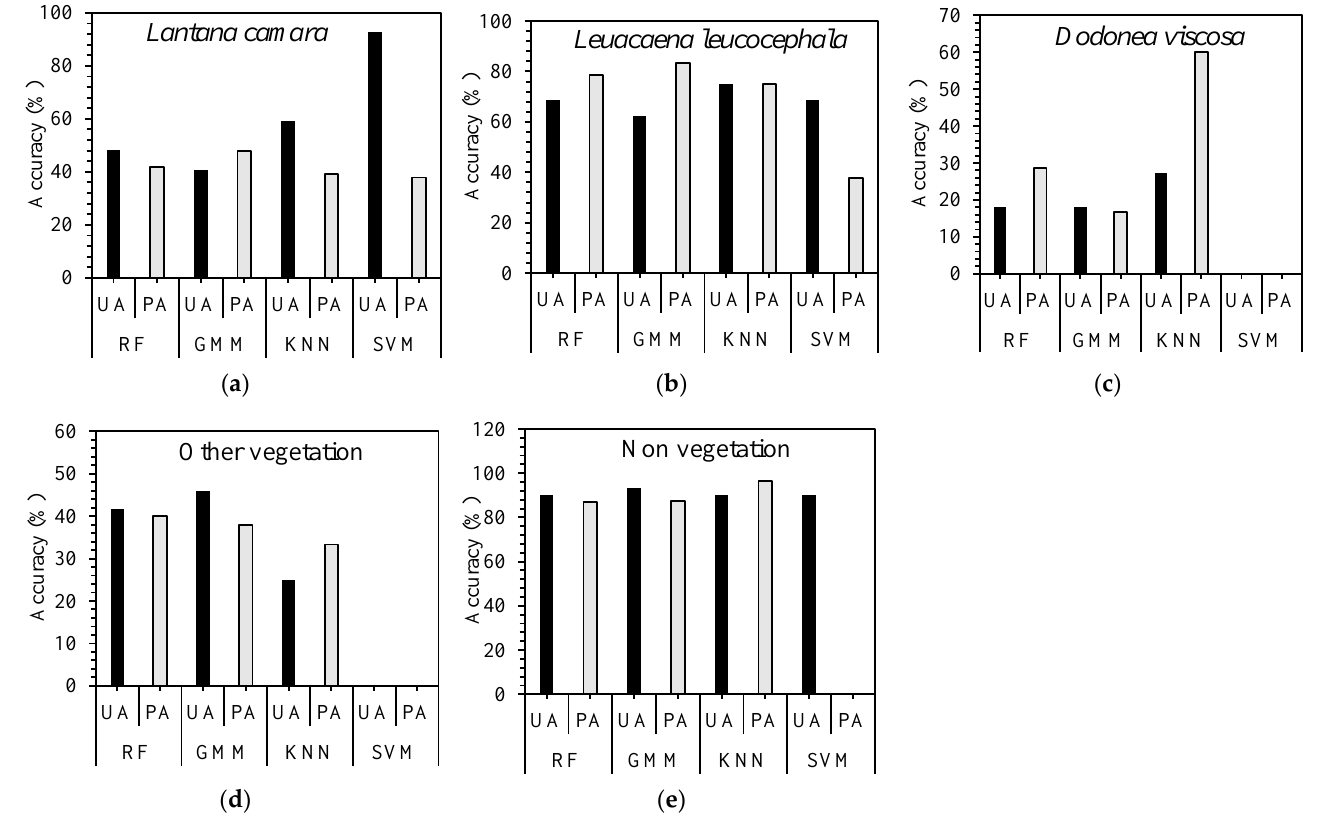
Figure 5. Graphical representation of user accuracy (UA) and producer accuracy (PA) for Sentinel- 2 data with all classes. Lantana camara , ( a ) Leucaena leucocephala , ( b ) Dodonaea viscosa , ( c ) other vege- tation, ( d ) and non-vegetation ( e ).